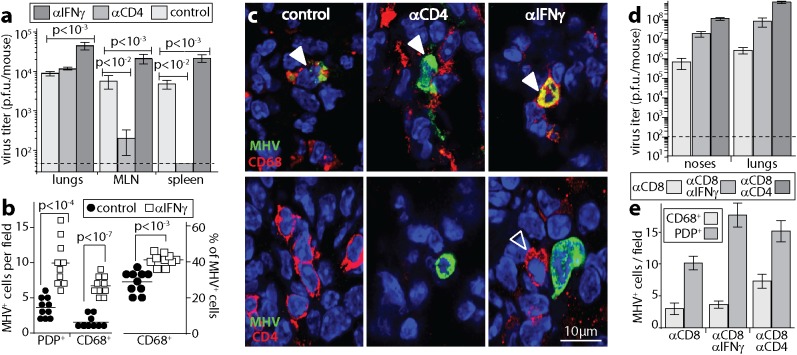
IFNγ neutralization also increases AM infection.a. C57BL/6 mice given IFNγ neutralizing antibody (αIFNγ), depleted of CD4+ T cells (αCD4) or left untreated (control), were given MuHV-4 i.n. (104 p.f.u.). 9d later lungs were plaque assayed for infectious virus, and mediastinal LN (MLN) and spleens infectious center assayed for latent virus. Bars = mean ± SEM of 6 mice per group. Dashed line = assay sensitivity limit. b. Mice were treated as in a. 9d later lung sections were stained for viral lytic antigens (MHV) plus CD68, PDP or CD4. Quantitation of staining showed that αIFNγ mice had significantly more MHV+ AEC1 and AM than controls, with AM accounting for a significantly greater proportion of all MHV+ cells. c. Examples of staining as quantitated in b. Nuclei were stained with DAPI. Filled arrows show example MHV+ AM. Red / green co-localization appears as yellow. The open arrow shows a CD4+ T cell adjacent to an infected cell. This was commonly observed after IFNγ neutralization. d. Mice were depleted of CD8+ T cells (αCD8), given also IFNγ neutralizing (αCD8αIFNγ) or CD4+ T cell depleting antibodies (αCD8αCD4), and all mice were then infected with MuHV-4 i.n. (104 p.f.u.). 9d later infectious virus was plaque assayed in noses and lungs. Bars = mean ± SEM of 6 mice per group. Dashed line = assay sensitivity limit. αCD8αIFNγ significantly increased titers above αCD8 and αCD8αCD4 significantly increased titers above αCD8αIFNγ (p<0.01). e. Lung sections of mice treated as in d were stained for MHV and cell type markers (CD68, PDP). Cells were counted for 3 fields of view per section, across 3 sections each of 3 mice per group. Bars = mean ± SEM counts of individual mice. αCD4αCD8 significantly increased CD68+ infected cell numbers over αCD8 alone (p<0.05). αIFNγ/αCD8 did not (p>0.2).